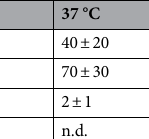
10 °C 37 °C k 1 (µM −1 s −1